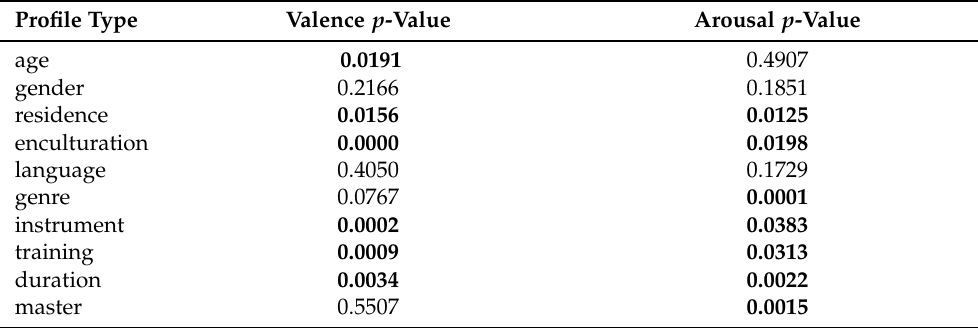
Table 3. Resulting p -values from the Kruskal Wallis tests run on each profile feature with valence and arousal ratings, respectively. Values in bold are statistically